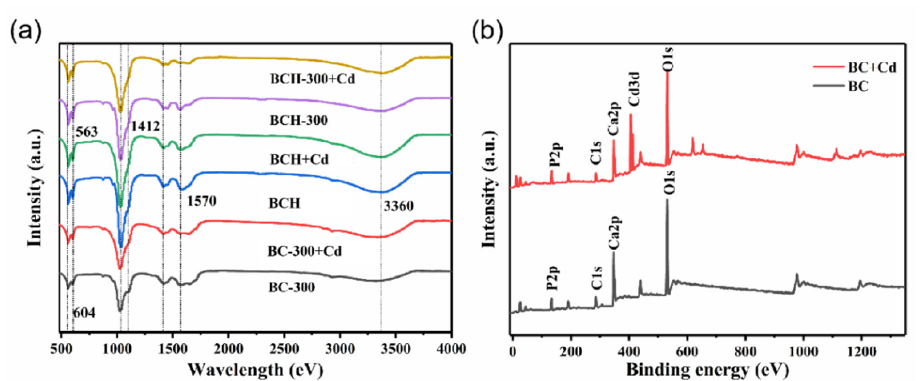
Figure 7. Analysis of BC and BCH samples before and after adsorbing Cd: ( a ) FT-IR spectra, ( b ) XPS survey spectra.